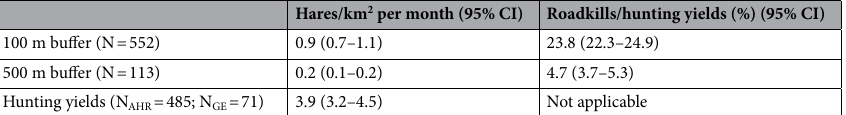
Table 4. Mean monthly hare accident density in the study area (5 months of sampling) and ratio of hare accident density to monthly hare hunting yields (3 months of hunting season) in neighboring hunting estates (1993–2001 average). N AHR number of annual hunting reports analyzed, N GE number of game estates.